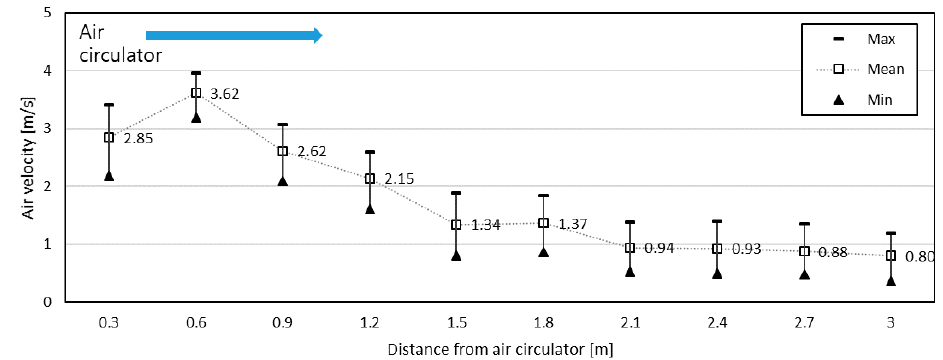
Figure 6. Air velocity measured in the direction of air flow by air circulator.